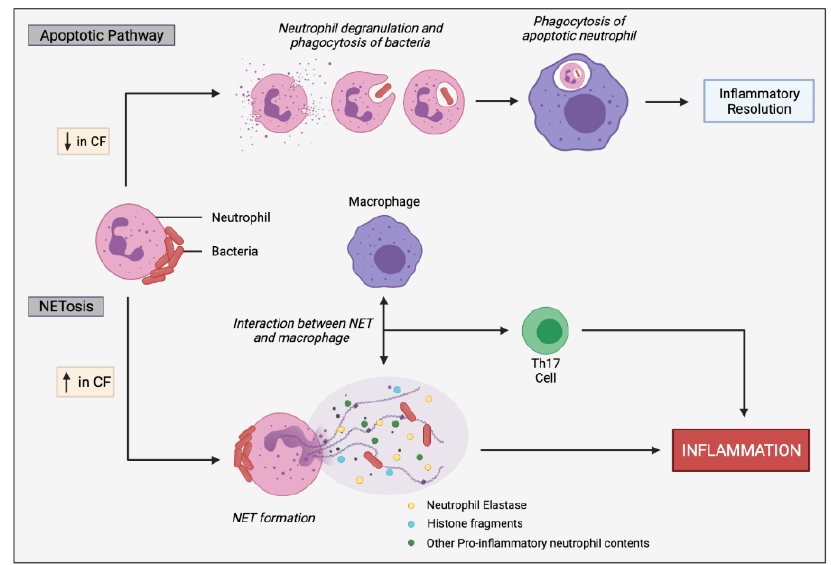
Figure 5. Simplified apoptotic and NETosis pathways in neutrophils. Normal apoptotic pathway involves neutrophil degranulation and phagocytosis of pathogens, initiating neutrophil apoptosis. The apoptotic neutrophil is then phagocytosed by macrophages promoting inflammatory resolution. CF neutrophils are biased towards undergoing NETosis in response to bacteria and other inflammatory stimuli, rather than the apoptotic pathway. In response to infectious stimuli, CF neutrophils expel NETs containing DNA, histone fragments and various pro-inflammatory neutrophil contents, such as neutrophil elastases which can directly or indirectly, through cell interactions, induce inflammation. Macrophages interact with the NETs, resulting in stimulation of Th17 cells, leading to neutrophil influx and further inflammation. Progressive inflammation triggered by sustained NET formation and release of toxic contents can damage the lung architecture.